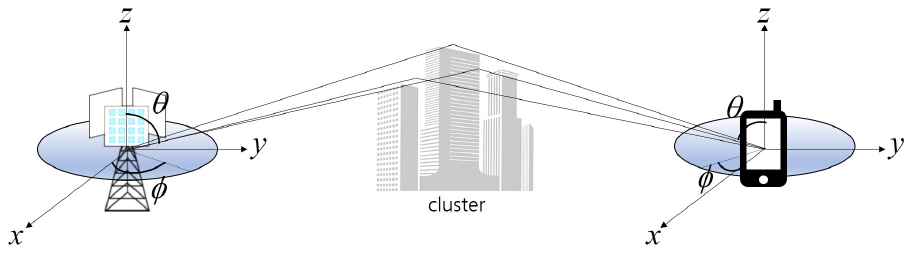
Figure 3. 3-dimension spatial channel model.